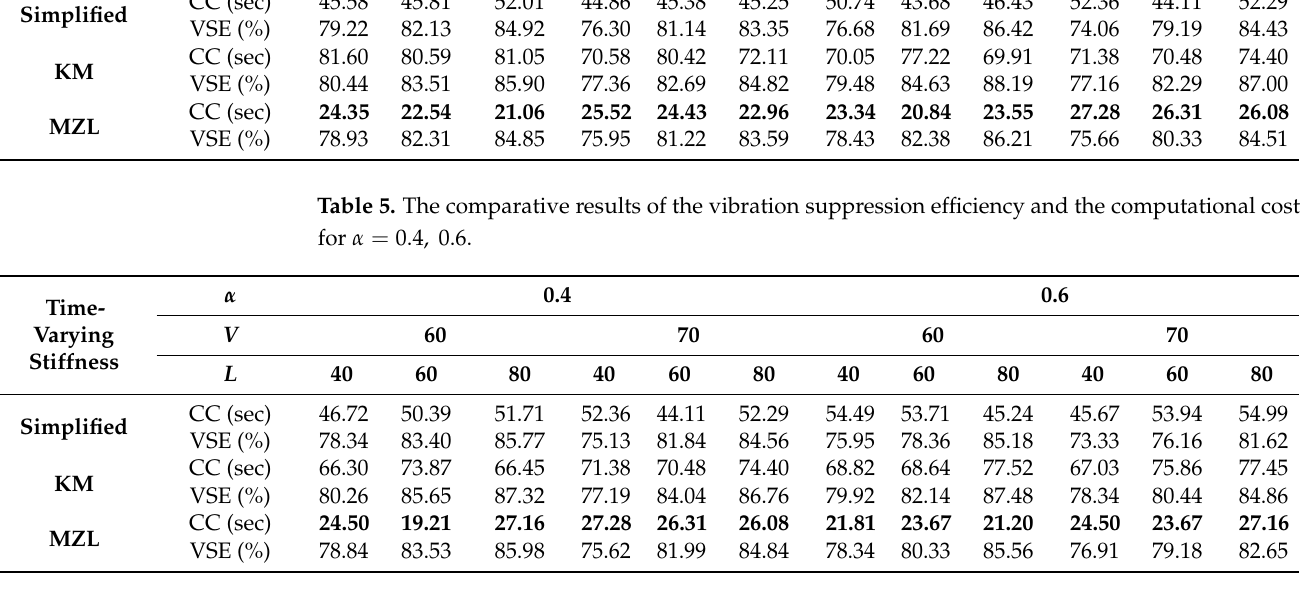
Table 5. The comparative results of the vibration suppression efficiency and the computational cost for